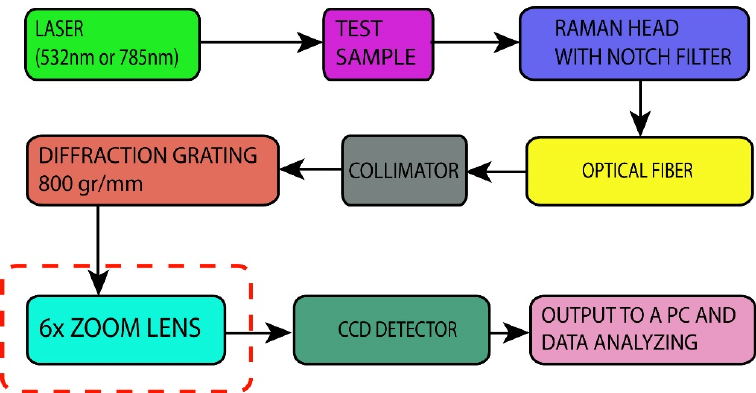
Figure 1. Schematic diagram of the proposed Raman spectrometer with an additional zoom lens component (red dashed rectangle) based on a typical Raman spectrometer configuration.